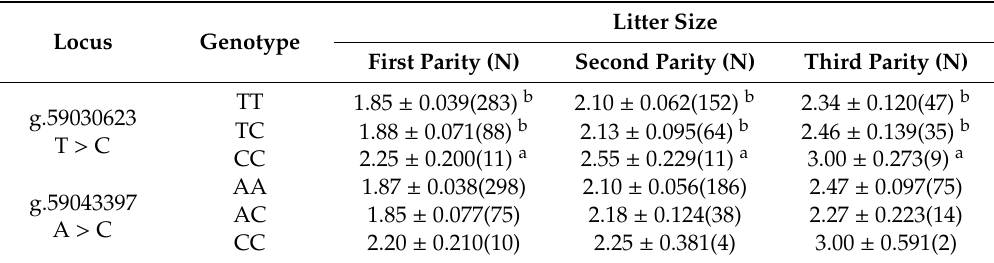
Table 5. Least squares mean and standard error of litter size in Small Tail Han sheep with di ff